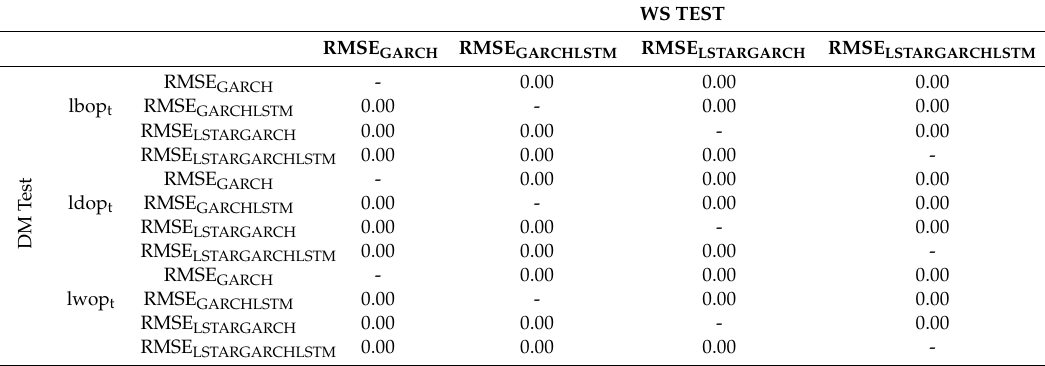
Table 10. Wilcoxon signed-rank and Diebold–Mariano